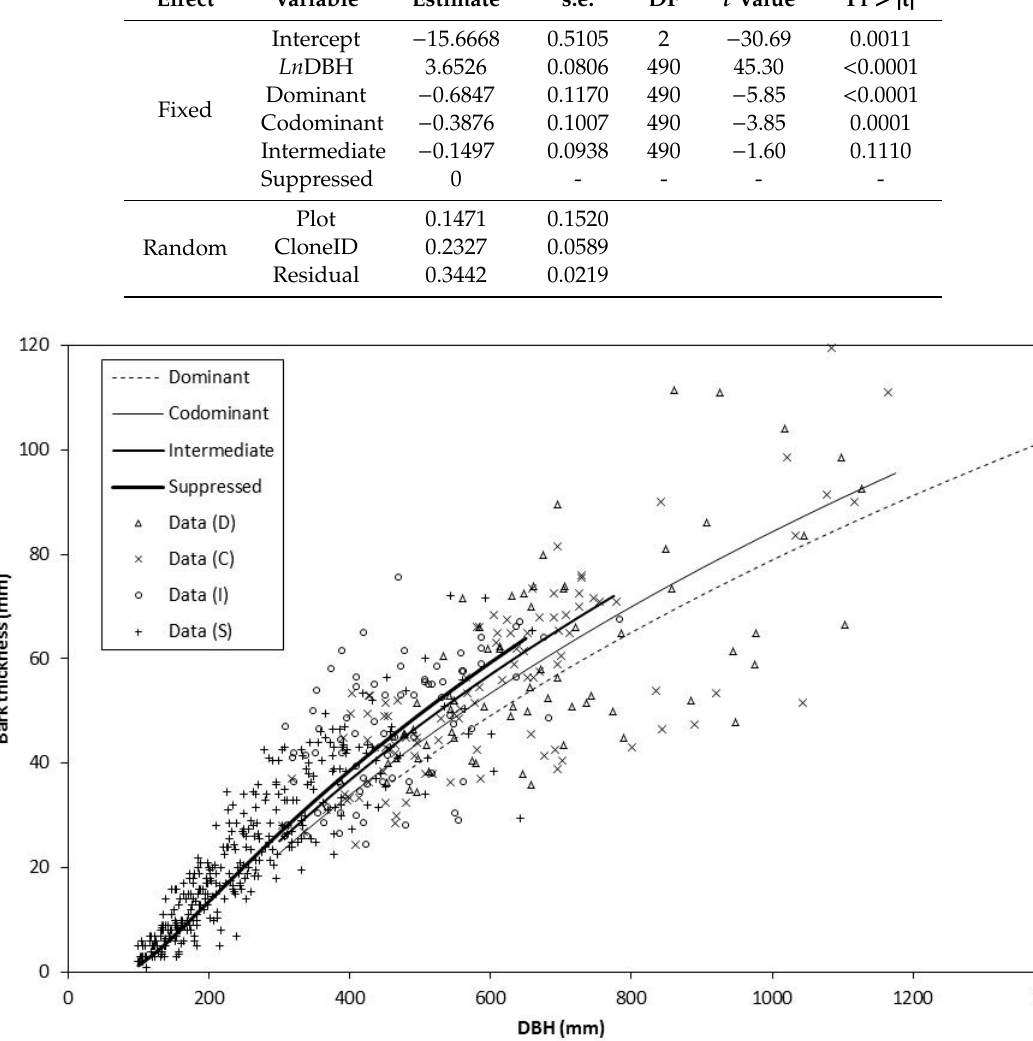
Table 6. Summary data for redwood trees in the northern, central, and southern parts of redwood’s natural range.